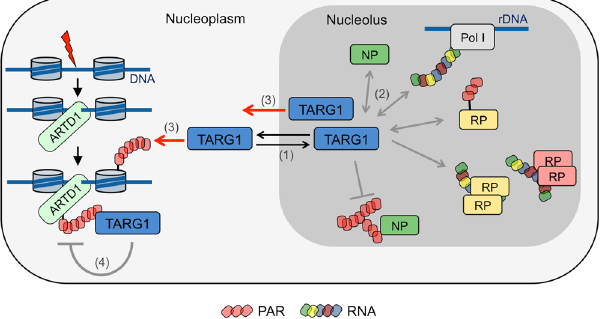
Figure 7. Model of a dual function of TARG1 in both RNA- and PAR-regulated cellular processes. Under steady-state conditions, TARG1 accumulates in nucleoli but constantly shuttles between nucleoli and the nucleoplasm (1). Accumulation of TARG1 in nucleoli is mediated by direct interaction with ribosomal RNA or proteins (RP) or other nucleolar proteins (NP; 2). PARylation modulates the localization and interactome of TARG1. TARG1 re-locates to the nucleoplasm upon DNA damage-induced ARTD1/2-dependent PARylation (3). In nucleoli, TARG1 may contribute to ribosome biogenesis, e.g., by counteracting PARylation of RPs or controlling nucleolar PAR scaffolds. DNA damage-induced PARylation might serve to sequester TARG1 to the nucleoplasm to regulate PAR turnover at DNA damage sites (4). Hypothetical interactions are marked by grey